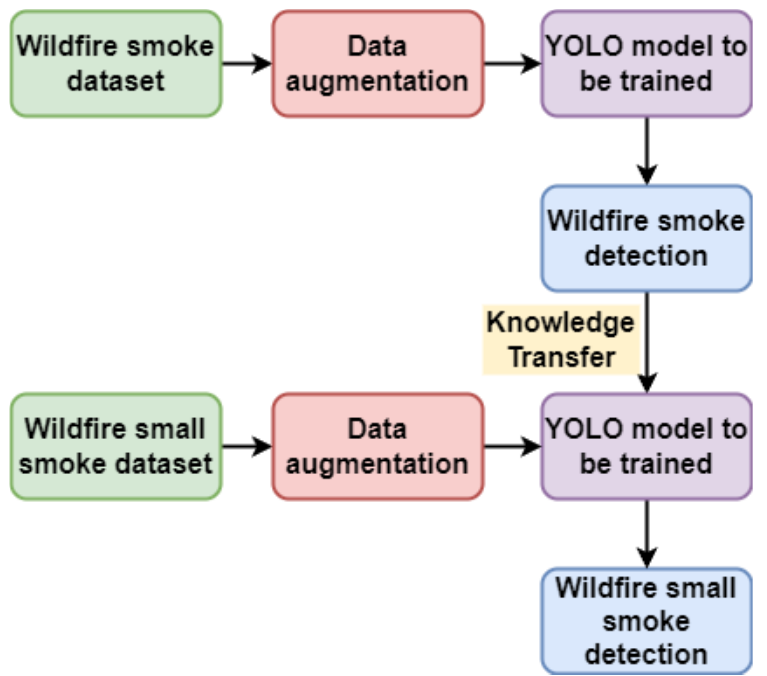
Figure 9. Transfer learning process of training the small-sized wildfire smoke detection